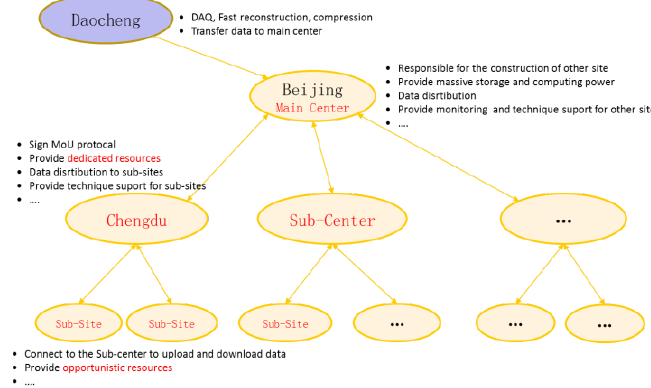
Figure 2. The schema of LHAASO distributed computing